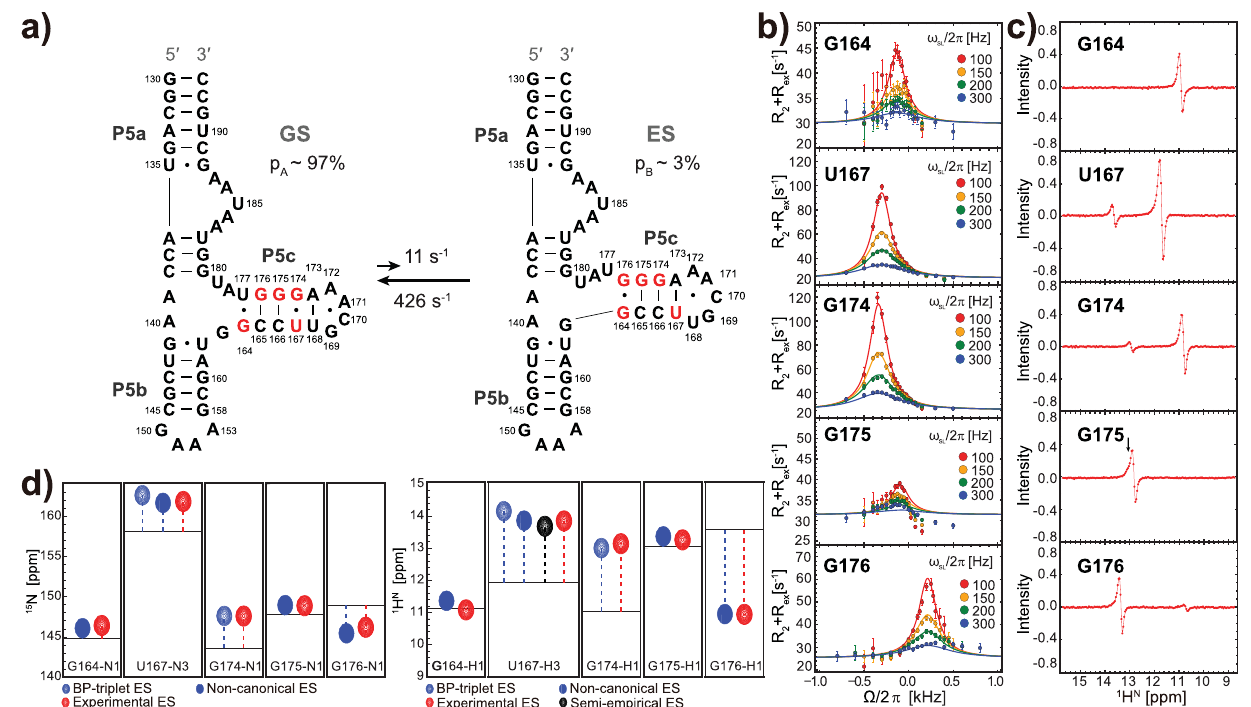
Fig. 7 Veri fi cation of P5abc ES secondary structure by using 15 N RD and 1 H N CEST, with the help of imino chemical shift prediction. a Secondary structure reshuf fl ing of P5abc in the absence of Mg 2 + . Residues showing pronounced RD are colored in red. G164 • G176 is a speculated non-native mismatch in the previous study. b Off-resonance 15 N R 1 ρ pro fi les of relevant residues in P5c stem. The on-resonance 15 N R 1 ρ pro fi les and 15 N CEST pro fi les are available in Supplementary Figs. 12 and 13, respectively. The error bars represent standard deviations (s.d.) estimated using Monte Carlo simulation with 50 iterations. c 1 H N CEST difference pro fi les of the same set of residues in P5c stem. The pro fi le of G175 shows an asymmetrical dip caused by a small Δ ω (black arrow). d Depiction of imino 15 N (left panel) and 1 H N (right panel) chemical shifts of the excited state relative to the ground state (horizontal lines), as measured by RD (red resonances), and predicted by BP-triplet table (blue resonances), individual noncanonical BP-triplet (solid blue resonances), or semiempirical method (black